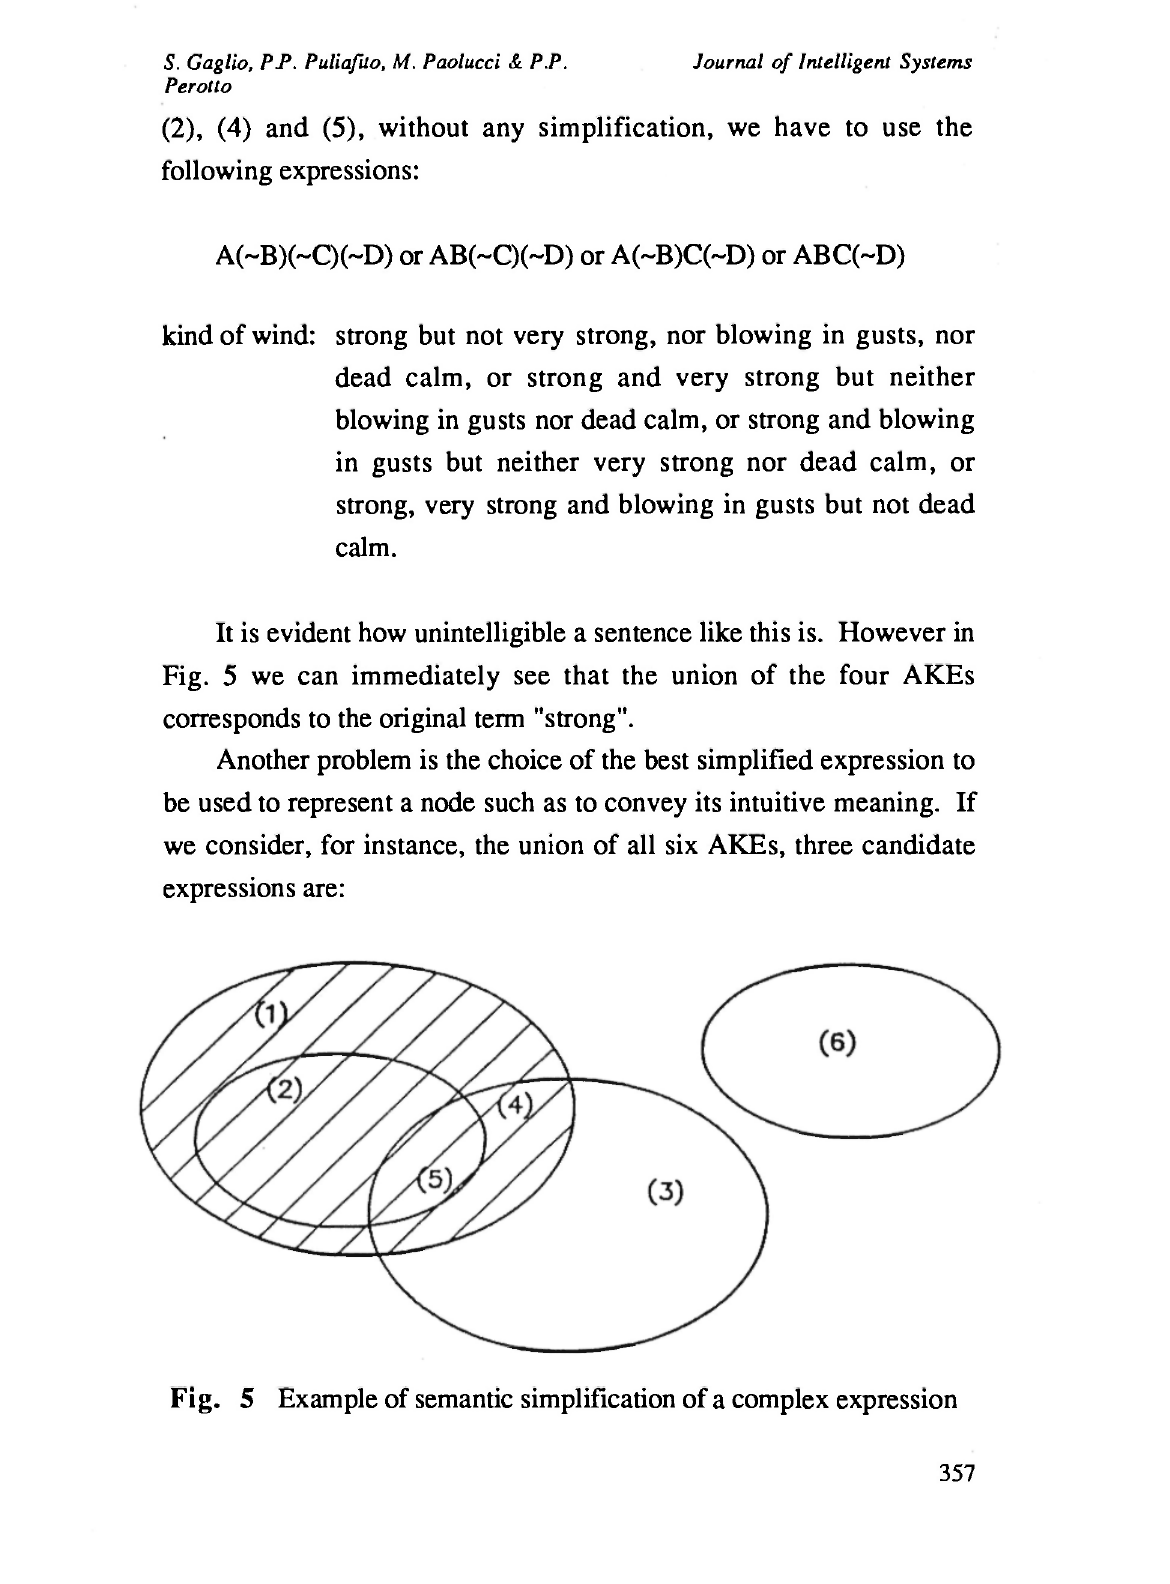
Fig. 5 Example of semantic simplification of a complex